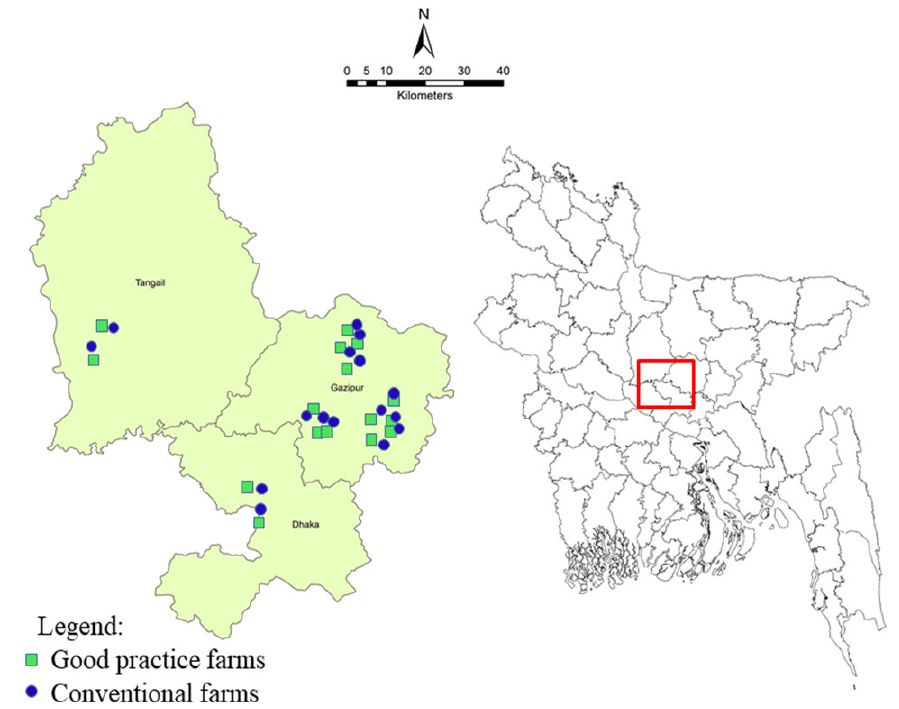
Figure 1. Location of broiler farms in three district of Bangladesh were included in this survey. Same number of farms were included in this study comprised of good practice broiler farms ( n = 16) and conventional farms ( n = 16) (4 farms from Dhaka, 4 from Tangail and 24 from Gazipur districts).